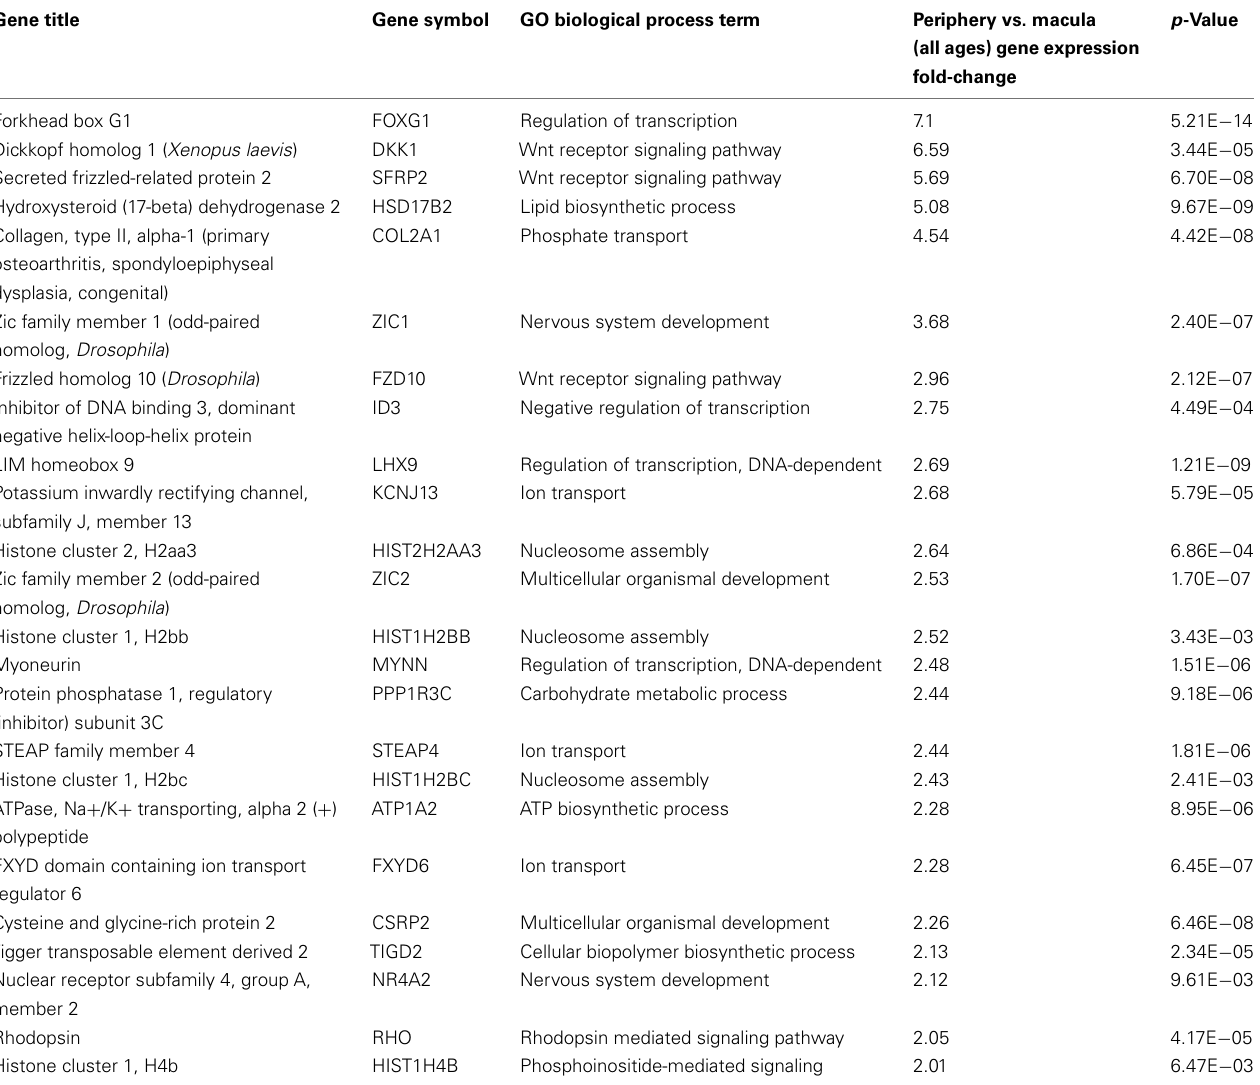
Table 4 | Genes highly expressed in peripheral compared to macular